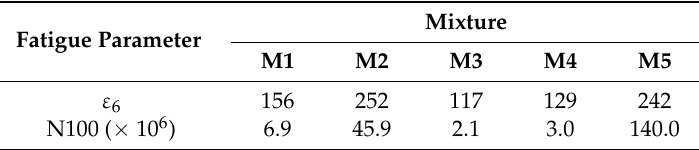
Table 5. Fatigue parameters, N100 and ε 6 , of the studied